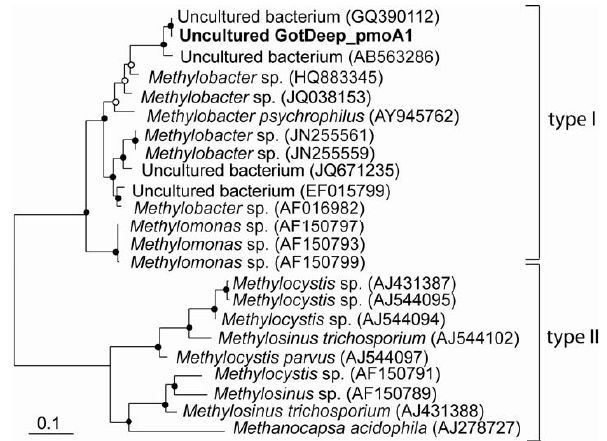
Fig. 3. Unrooted maximum likelihood tree showing the phyloge- netic affiliation of the partial pmoA DNA sequence generated from Figure 3. Unrooted maximum likelihood tree showing the phylogenetic affiliation of the partial the filter samples taken in 80, 100, 105 and 119m water depth (marked bold). Black circles = validation of subtree by neighbour- pmoA DNA sequence generated from the filter samples taken in 80, 100, 105 and 119 m water joining and parsimony; white circles = validation of subtree by depth (marked bold). Black circles = validation of subtree by neighbor-joining and parsimony; parsimony; black diamond = validation of subtree by neighbour- joining. Scale bar represents 10 substitutions per 100 nucleotides. white circles = validation of subtree by parsimony; black diamond = validation of subtree by For tree construction partial amoA sequences were used as an out- group (not shown). neighbor-joining. Scale bar represents 10 substitutions per 100 nucleotides. For tree construction partial amoA sequences were used as an outgroup (not shown).